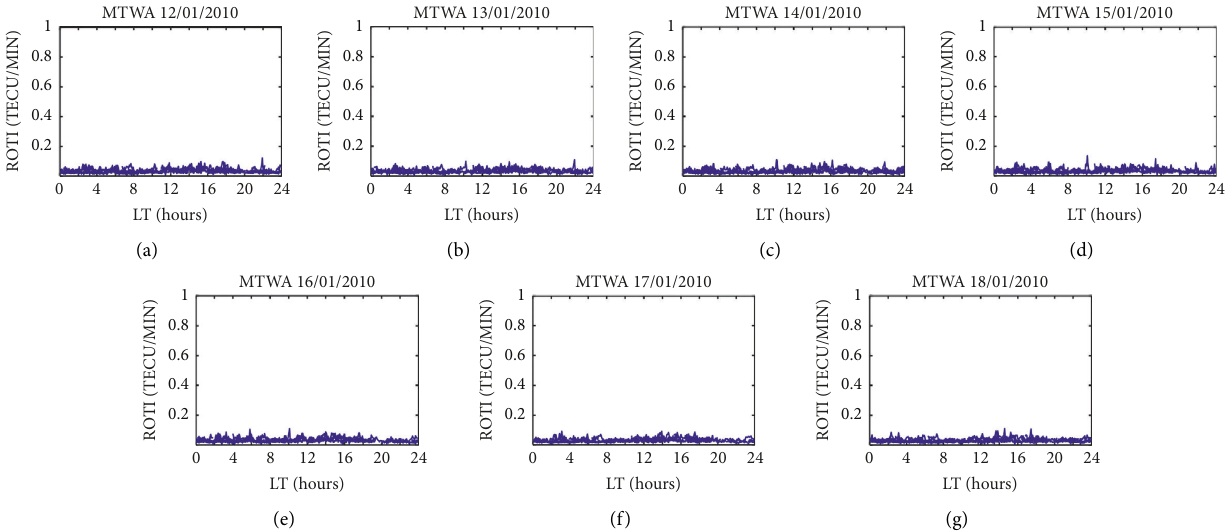
Figure 16: ROTI against LTover MTWA station for (a) 12 th January 2010, (b) 13 th January 2010, (c) 14 th January 2010, (d) 15 th January 2010, (e) 16 th January 2010, (f) 17 th January 2010, and (g) 18 th January